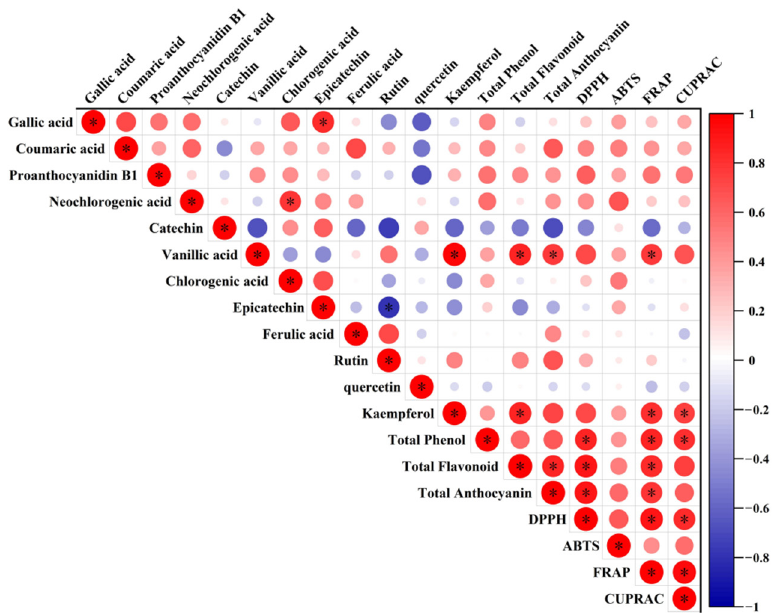
Figure 6. The correlations between phenolic compounds and antioxidant activity. Strong and weak correlations are indicated by the large and small circles, respectively. The color of the scale bar denotes the nature of the correlation; 1 indicates a perfect positive correlation (red), and − 1 indicates a perfect negative correlation (blue). Significant correlations ( p ≤ 0.05) are indicated by *.